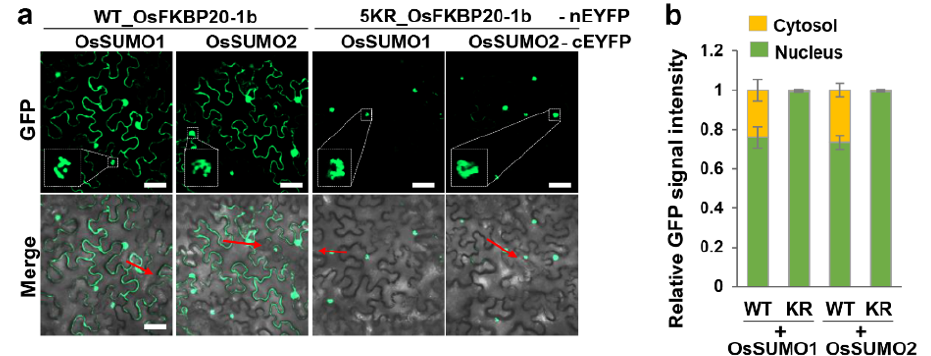
Figure 2. 5KR_OsFKBP20-1b affects cytoplasmic interaction with SUMO proteins. ( a , b ) Subcellular interaction between WT_OsFKBP20-1b or 5KR_OsFKBP20-1b and OsSUMO1/2 by BiFC assay. OsSUMO1, 2 and 3 constructs were cloned into pSPYCE (cEYFP) vector and OsFKBP20-1bs were cloned into pSPYNE (nEYFP) vector. Each construct was transformed into A. tumefaciens (GV3101) and infiltrated to leaves of 4-week-old N. benthamiana . ( a ) Two days after infiltration, the leaves were observed using a confocal microscope. Bar = 50 μ m. ( b ) Relative GFP signal intensity of WT or 5KR_OsFKBP20-1b interacting with OsSUMOs. The signal intensity was measured by profiling process of ZEN system. Red arrows in ( a ) represent the one of the profiling data. Error bar was standard deviation ( n = 20 cells).